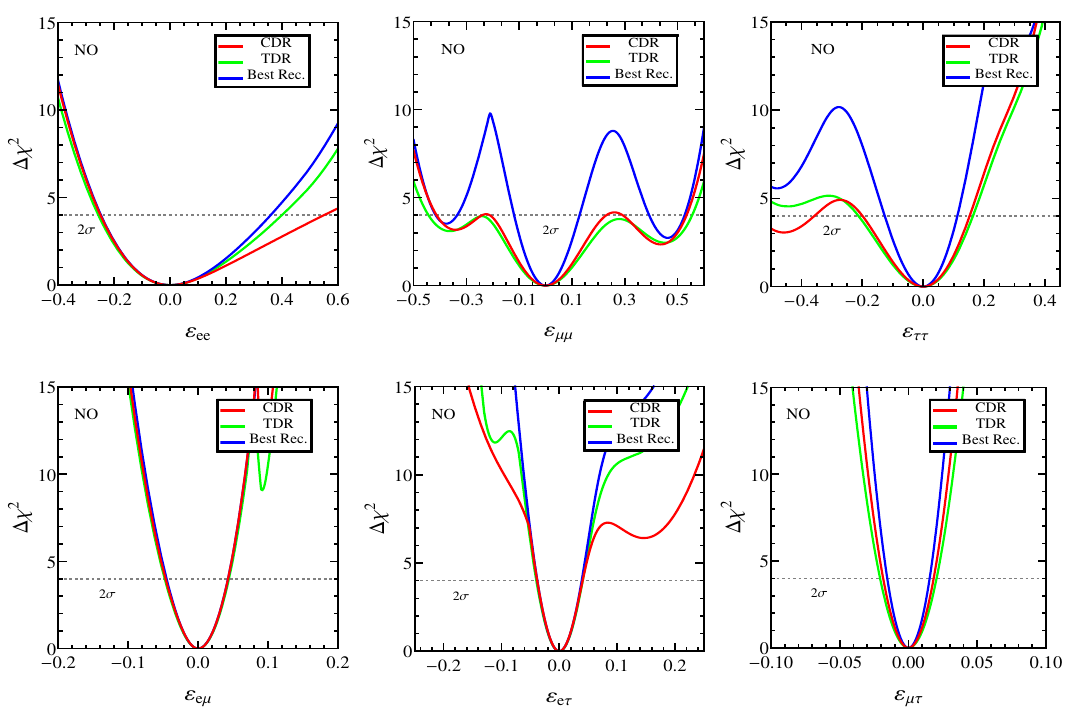
Figure 3 . One-dimensional projections of the DUNE sensitivity to the diagonal NSI parameters ε ee , ε µµ , ε ττ in the upper panel and non-diagonal ε eµ , ε eτ , ε µτ in the lower panel. The red line represents the result with “CDR” configuration, black line is for the “TDR” configuration, and the blue line corresponds to the “Best Reconstruction” configuration. Normal mass ordering is assumed in the data as well as in the theory. We have considered δ CP (true) = − 90 ◦ and the non-diagonal NSI parameters as